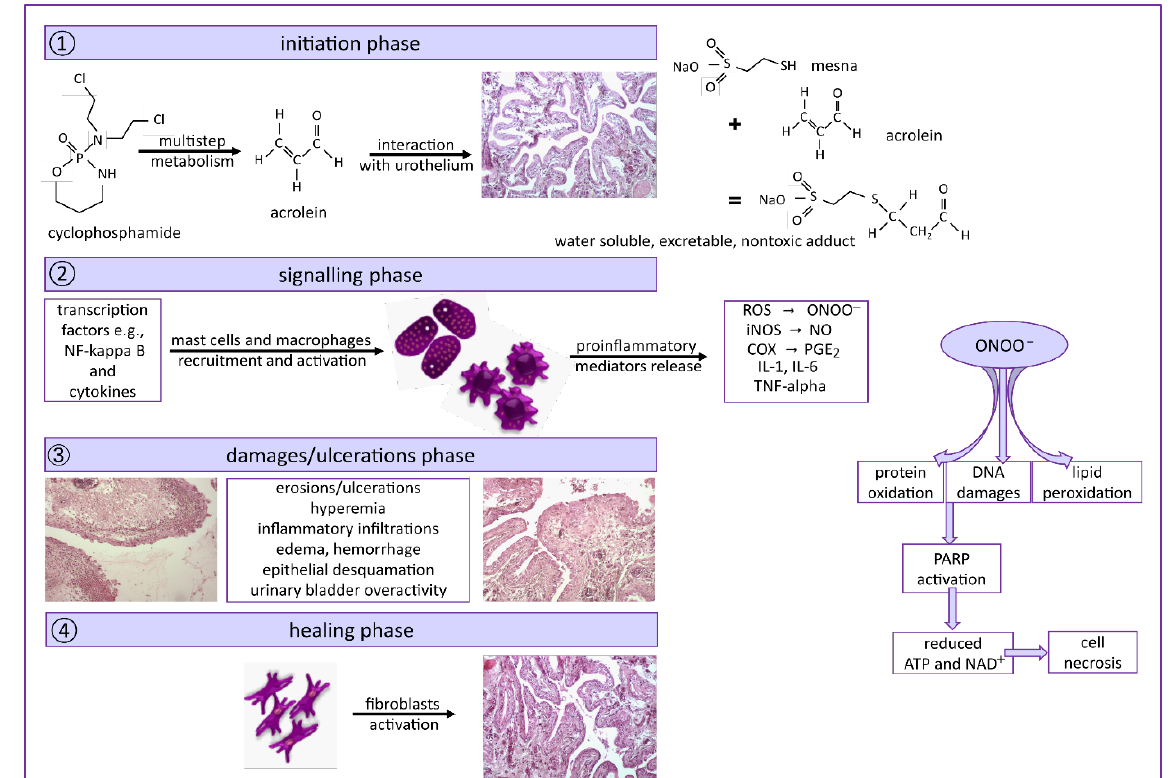
Figure 8. The proposed mechanism of urinary bladder toxicity induced by cyclophosphamide, based on [7,31–33]. ROS—reactive oxygen species, ONOO – —peroxynitrite, iNOS—inducible nitric oxide synthase, NO—nitric oxide, COX—cyclooxygenase, PGE 2 —prostaglandin E 2 , IL-1—interleukin 1, IL-6—interleukin 6, TNF-α—tumor necrosis factor-alpha, NF-κB—nuclear factor kappa B, PARP—poly (ADP-ribose) polymerase, ATP—adenosine triphosphate, NAD + —an oxidized form of nicotinamide adenine dinucleotide. Images magnification 100×.